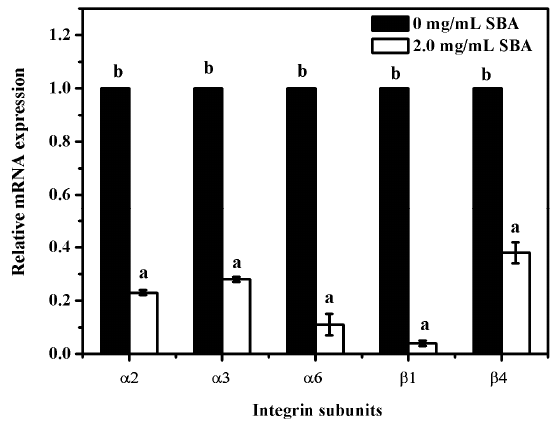
Figure 6. Relative mRNA expression of integrin subunits after stimulation by SBA. The mRNA levels of integrins ( α 2, α 3, α 6, β 1, β 4) were measured by qRT-PCR when IPEC-J2s were treated with 0 or 2.0 mg/mL SBA for 24 h. Means with different superscripts are significantly different in compare with its control. Each column is depicted as a mean ± SEM of three independent experiments.